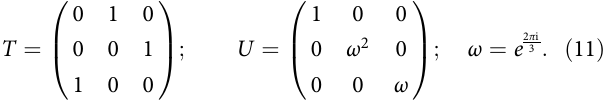
constructed a dissipative evolution that drives the system into the DDS, we discuss how the system approaches the DDS. We analyze the Lindbladian evolution with the quantum jump operators (8) numerically. The decay into the DDS is evaluated using a quench protocol: the system is initiated in the CDW state (cid:6)(cid:7) (cid:6) (cid:6)(cid:7) (cid:6) ¼ j i , which is one of the dark states of the Lindbladian at β = 0. This state is evolved then using the Lindblad operators (8) with A = B = t = 1 and β ∈ [0, 1] for simplicity (the results are qualitatively similar for slightly varying these parameters). In order to obtain the evolution of the system we perform exact diagonalization using Runge – Kutta (RK) integration 34 of the master equation, for systems of sizes up to L = 15.